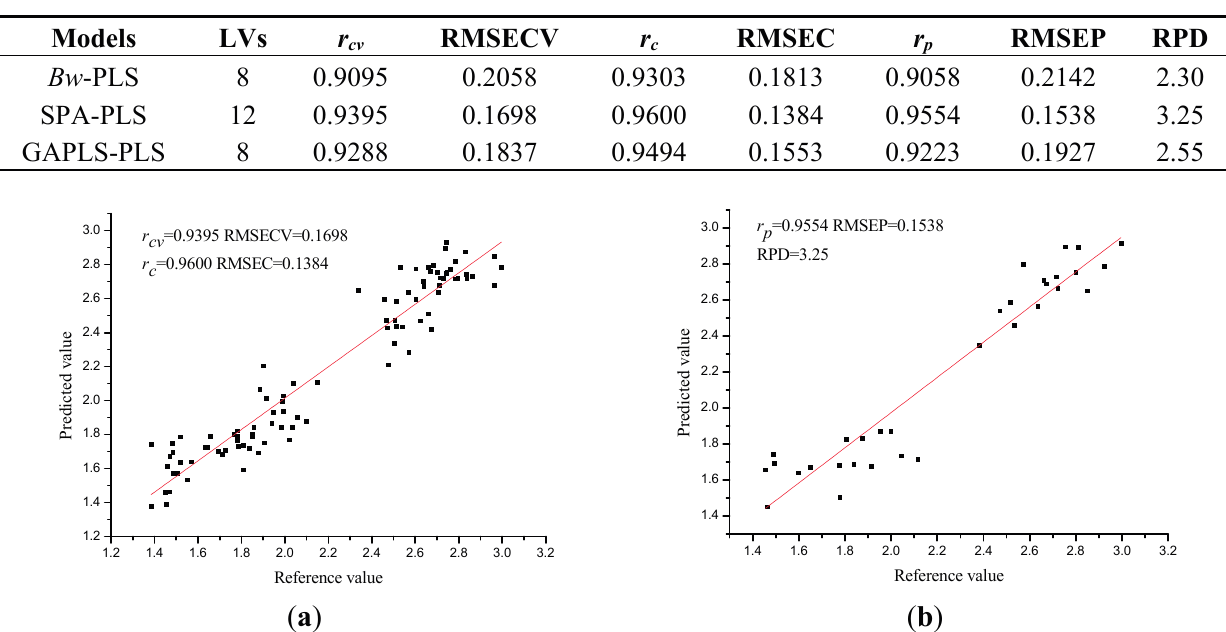
Table 3. Results of PLS model using sensitive wavelengths selected by weighted regression coefficients ( Bw ), SPA and GAPLS.